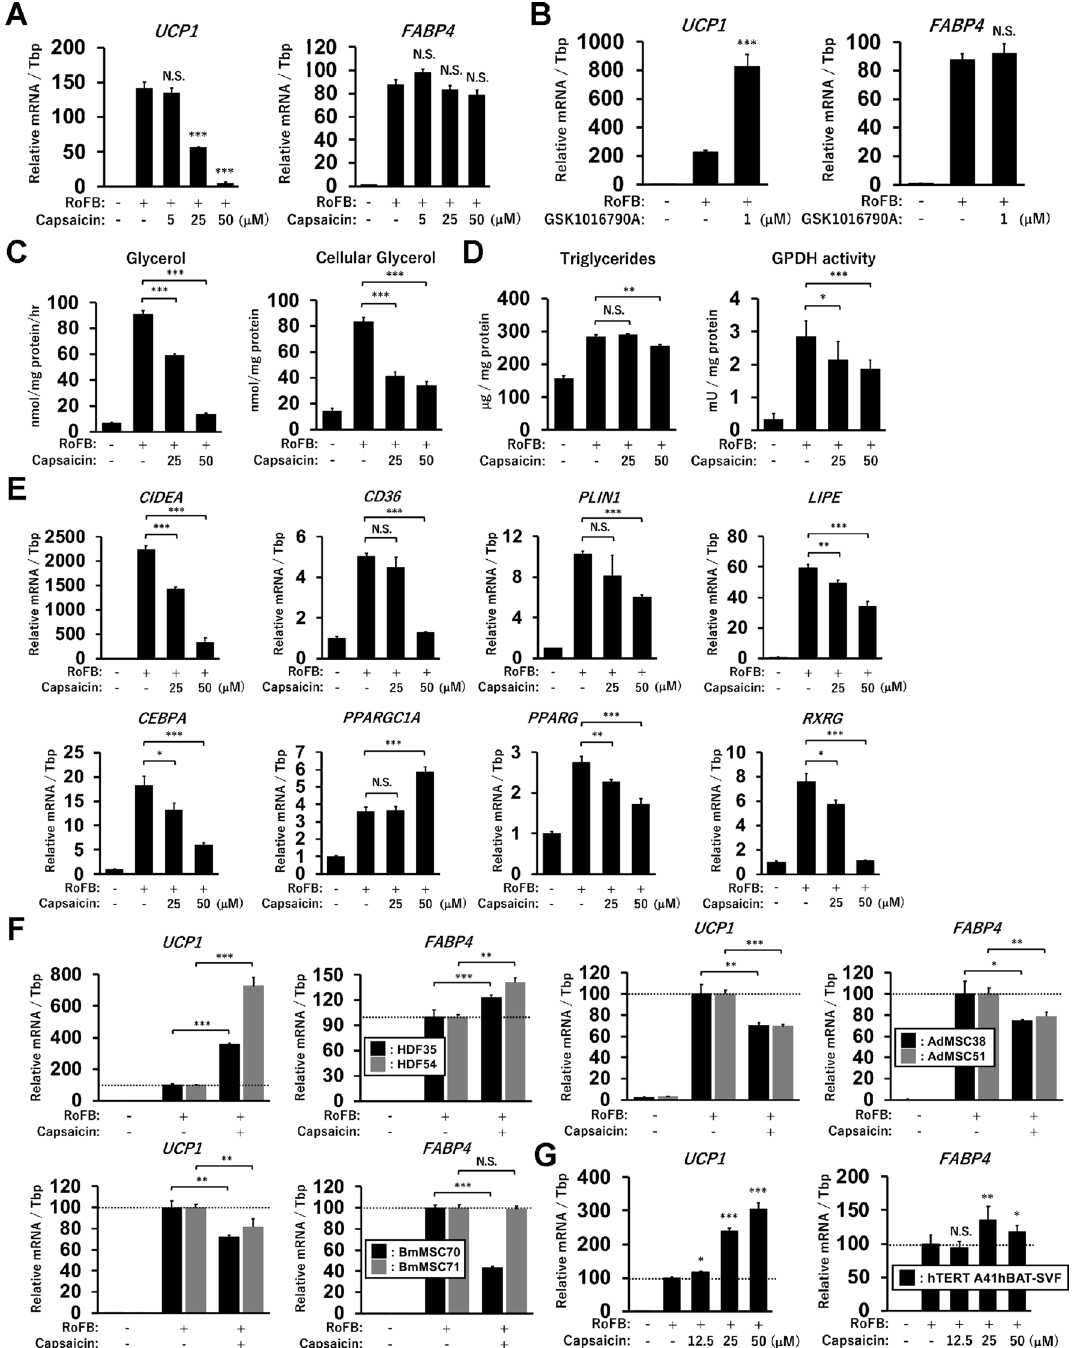
Figure 6. Effects of Capsaicin in adipose tissue-derived mesenchymal stem cell (AdMSC)-derived adipocytes. ( A ) The expression of UCP1 and FABP4 was quantified in AdMSC-derived adipocytes differentiated in the presence of Capsaicin at different concentrations as indicated. ( B ) The qRT-PCR analysis was performed in the adipocytes differentiated in the presence of GSK1016790A. ( C ) Glycerol secretion and cellular glycerol levels were quantified in AdMSC-derived adipocytes treated with Capsaicin at 25 μM and 50 μM. ( D ) Triglyceride content and GPDH activity were measured. ( E ) The expression of metabolic genes and transcription factors analysed in ciBAs was quantified. ( F ) Expression change of UCP1 and FABP4 by Capsaicin treatment at 25 μM was evaluated in ciBAs derived from two different HDFs (HDF35 and HDF54) and in the adipocytes derived from AdMSCs (AdMSC38 and AdMSC51) and BmMSCs (BmMSC70 and BmMSC71). ( G ) The expression was also measured in adipocytes differentiated from an immortalised human brown preadipocyte cell line (hTERT A41hBAT-SVF). Data represent mean ± SD (n = 3). Student’s t -test: * P < 0.05, ** P < 0.01, *** P < 0.001, N.S.; not